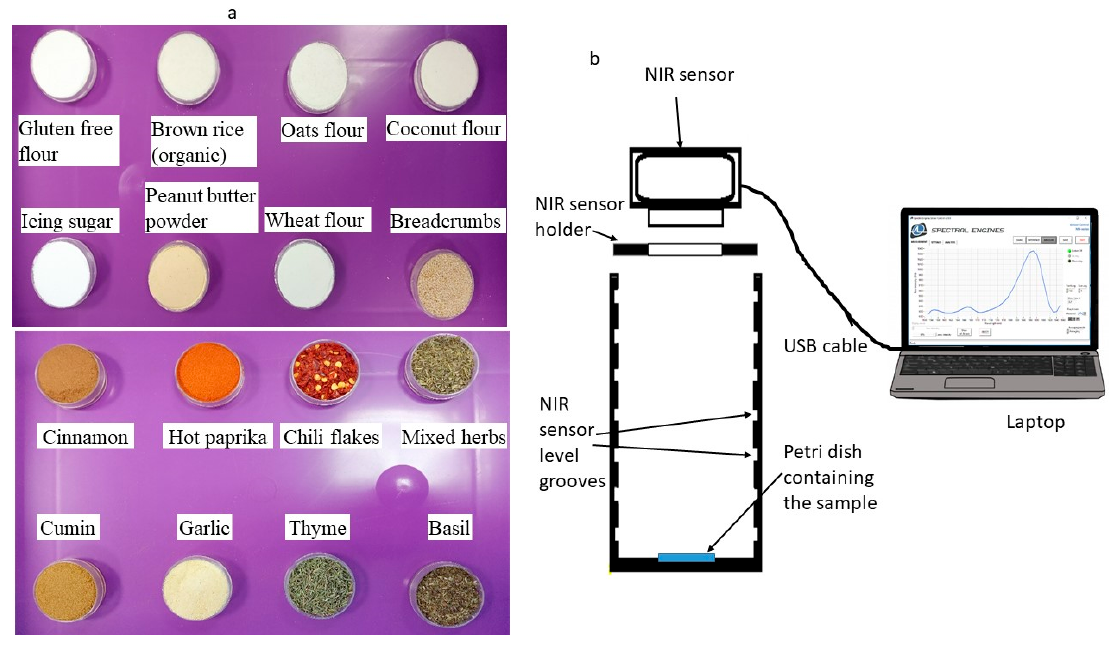
Figure 1. ( a ) Examples of different tested food materials, ( b ) NIR experimental system setup.